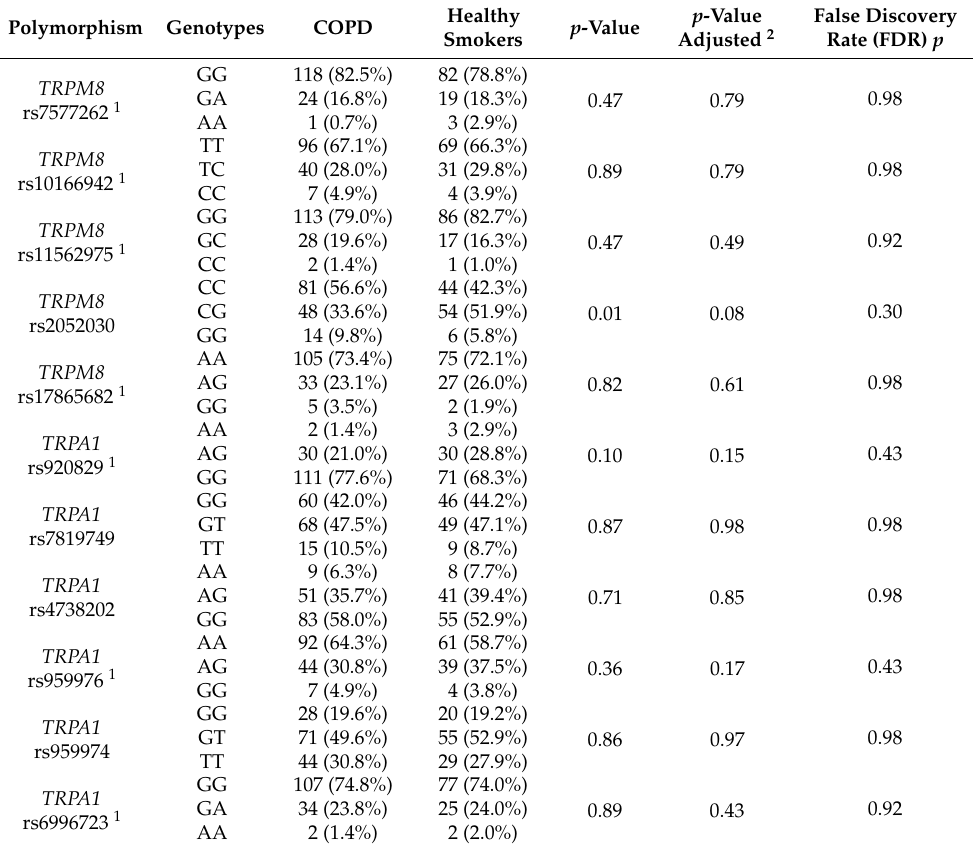
Table 3. Genotype frequencies of the studied polymorphisms in COPD patients and control